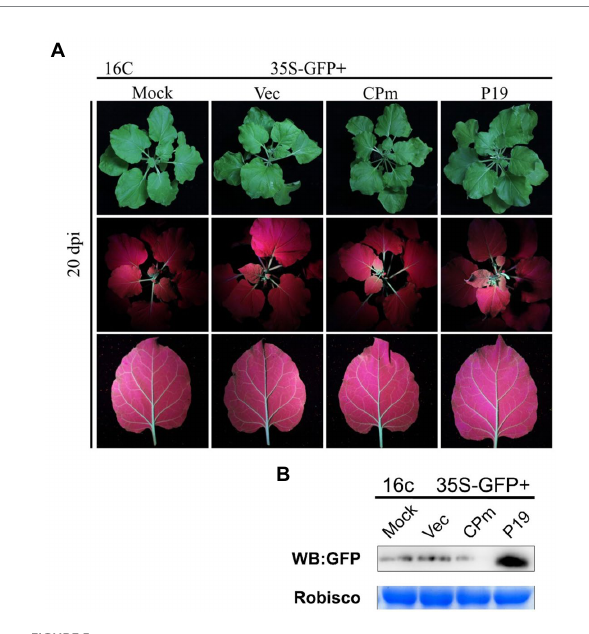
FIGURE 5 Tomato chlorosis viru s CPm protein not suppressing systematic RNA silencing triggered by GFP dsRNA. (A) Photographs taken under the white and UV light of Nicotiana benthamiana 16c leaves at 20 days post-infiltration (dpi) with Agrobacterium tumefaciens harboring 35S-GFP, either in combination with the pBIN19-3HA empty vector (Vec), or with constructs expressing CPm or P19 . (B) Western blotting analysis of GFP protein extracted from the zones infiltrated with Agrobacterium tumefaciens harboring the constructs indicated above each lane at 20 dpi.